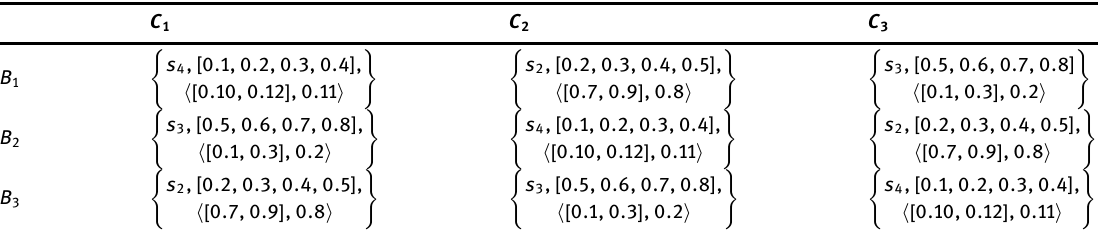
Table 1: Linguistic Variables of Rating of Alternatives by Decision